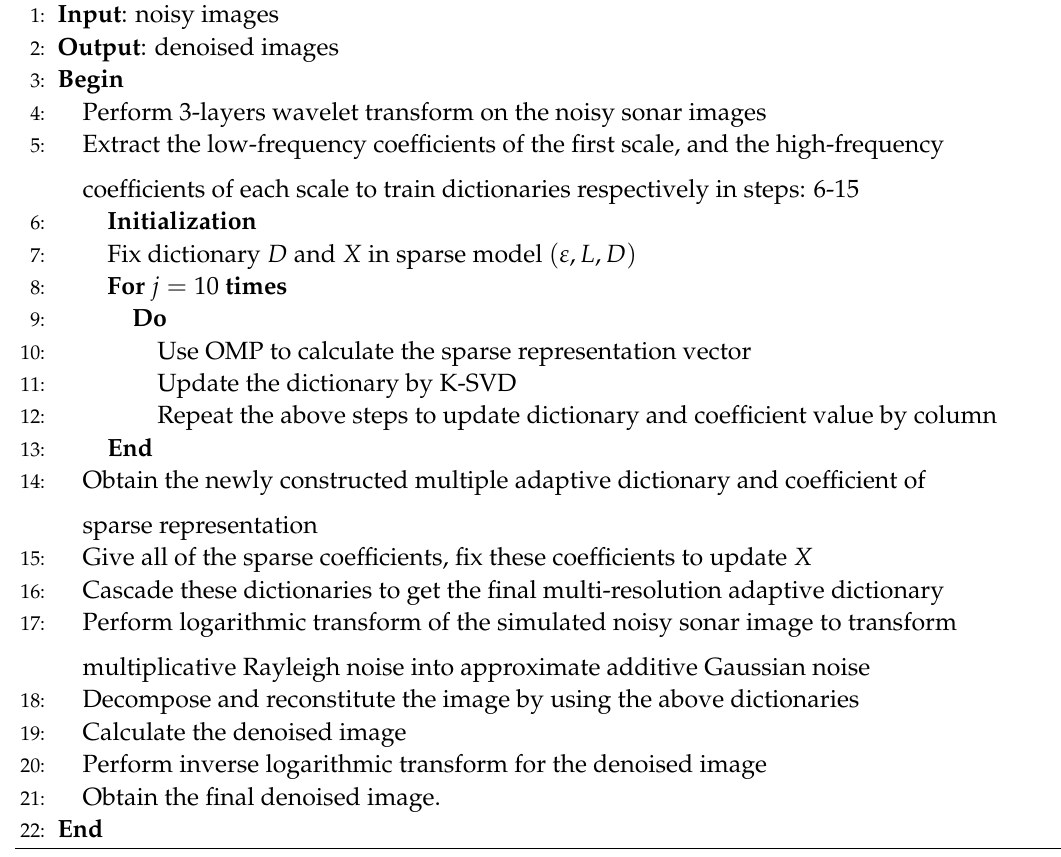
Algorithm 2 The proposed denoising